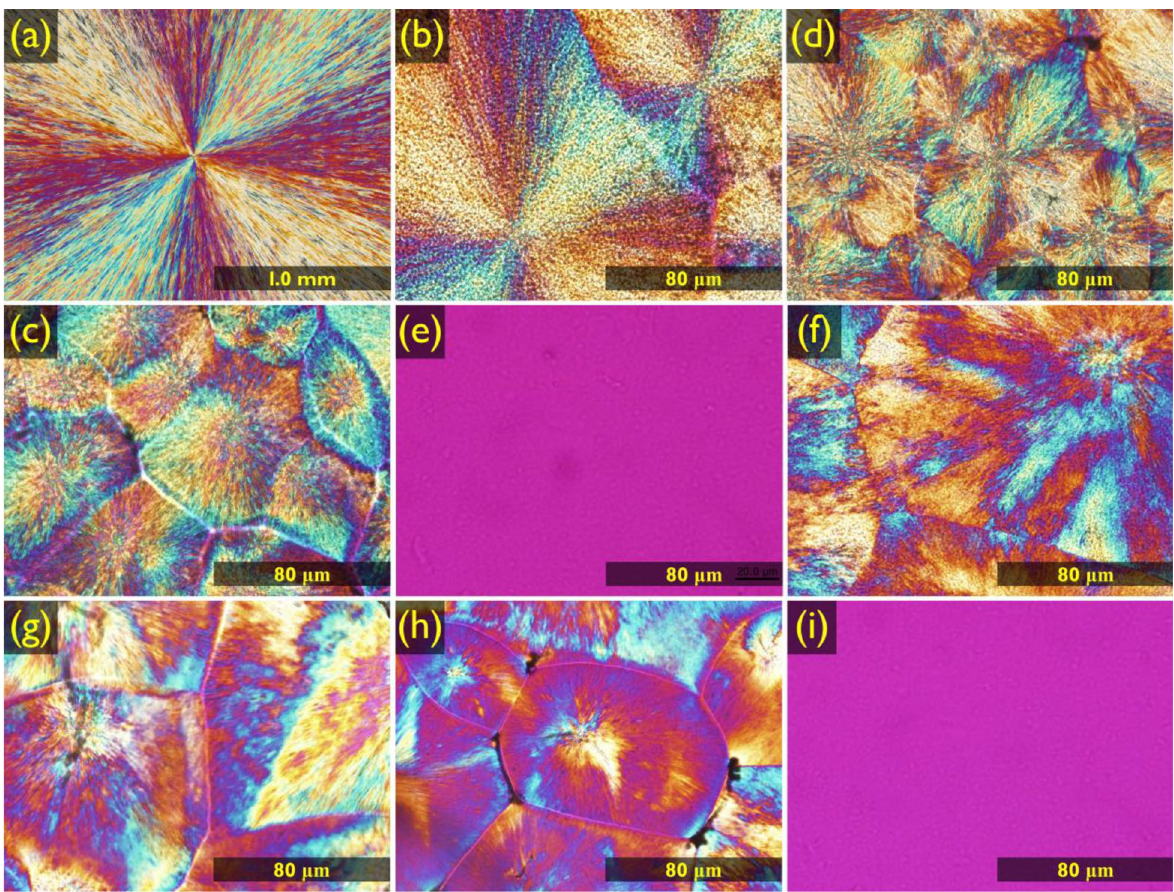
Figure 3. POM images of the ( a ) pristine PEG, ( b ) M.CO, ( c ) M.COM, ( d ) M.COT, ( e ) M.COT above 90 °C, ( f ) H.CO, ( g ) H.COM, ( h ) H.COT, and ( i ) H.COT above 90